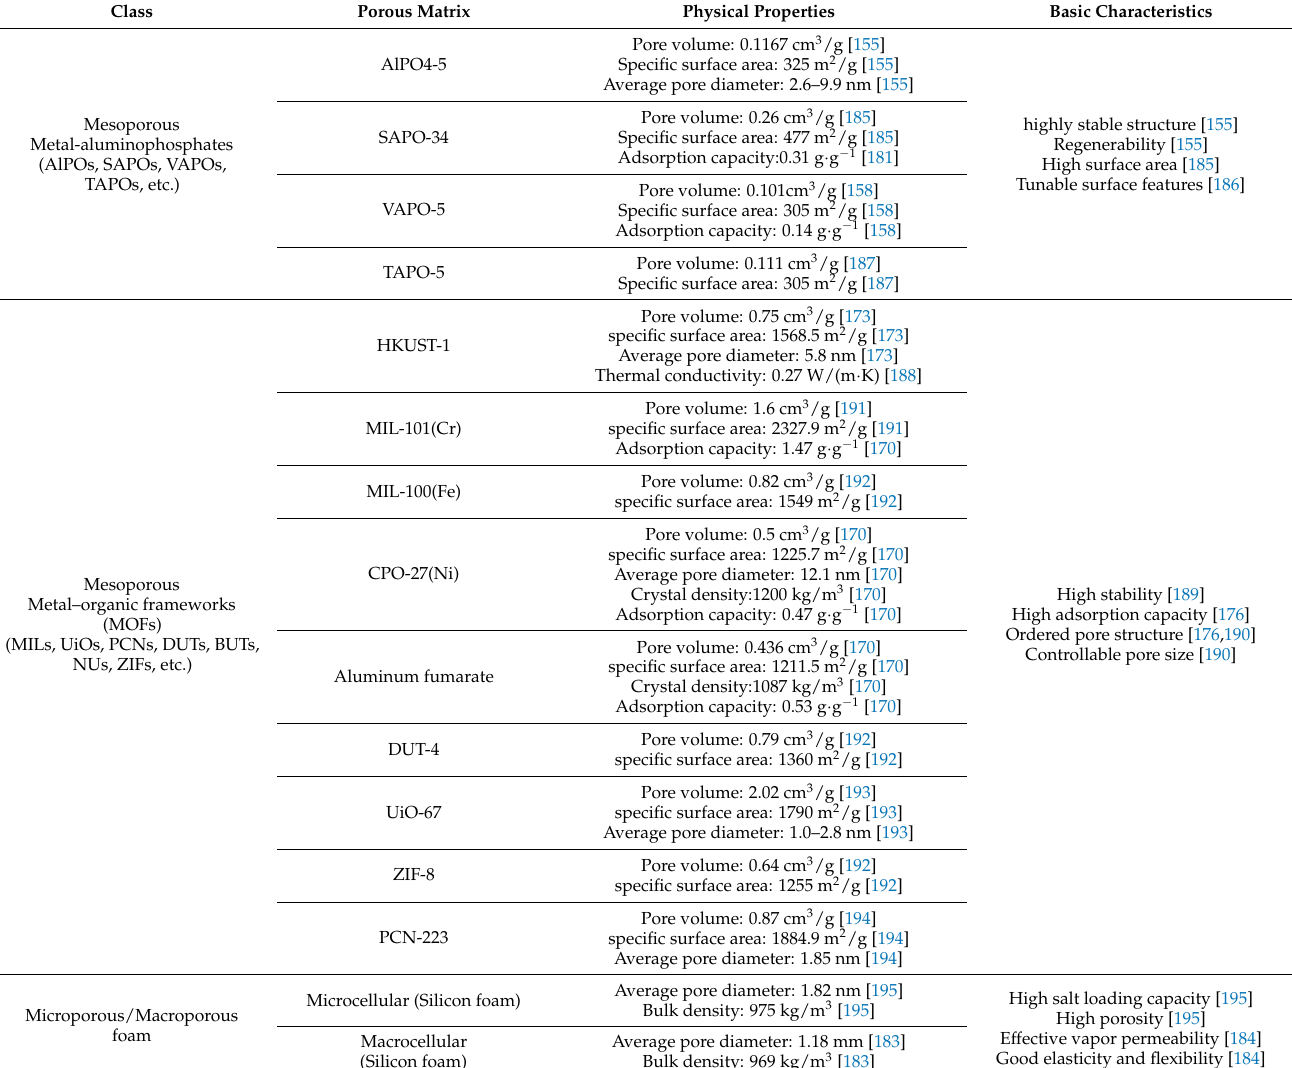
Table 6. Basic characteristics of potential porous